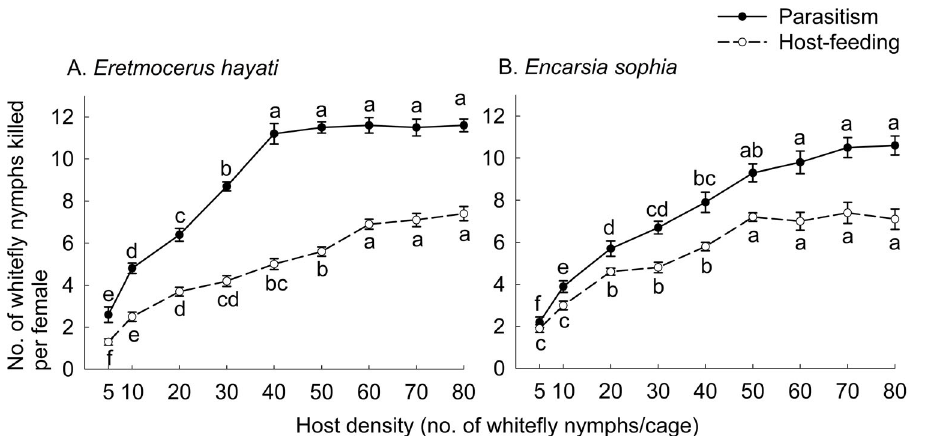
Figure 1. Mean number of whitefly nymphs killed by parasitism or host-feeding by parasitoid in single-instar experiment. A, B: killed by 1 d-old Eretmocerus hayati or Encarsia sophia in 24 h, respectively. An area of 3.5 cm 2 of a leaf on a potted tomato plant was covered by a clip cage. Data points with different lowercase letters in each line indicate significant differences (HSD test; P , 0.05) in number of hosts parasitized (continuous line) or fed (broken line). Vertical bars indicate 6 one SE.